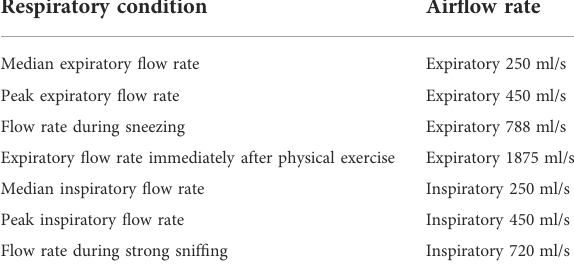
TABLE 1 Boundary air fl ow rates under different respiratory conditions.